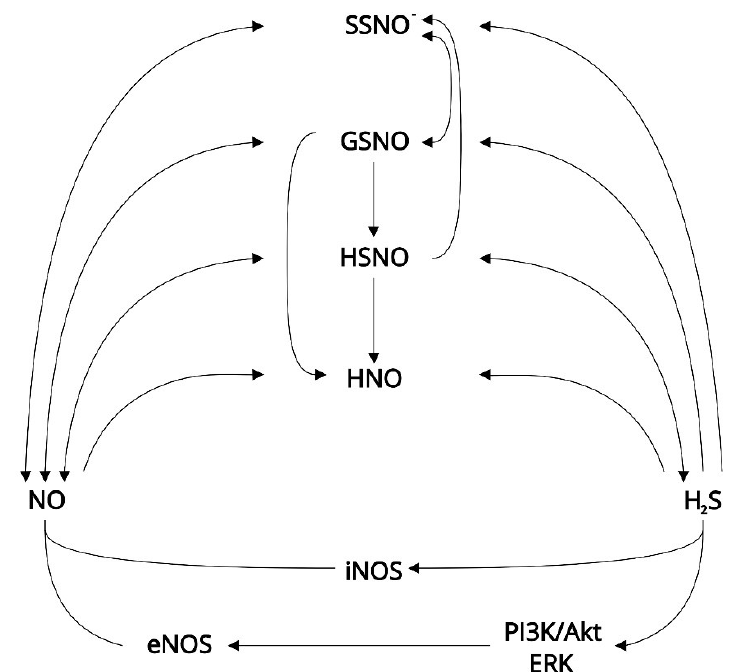
Figure 2. A brief insight into the interactions between NO and H 2 S that might be relevant for